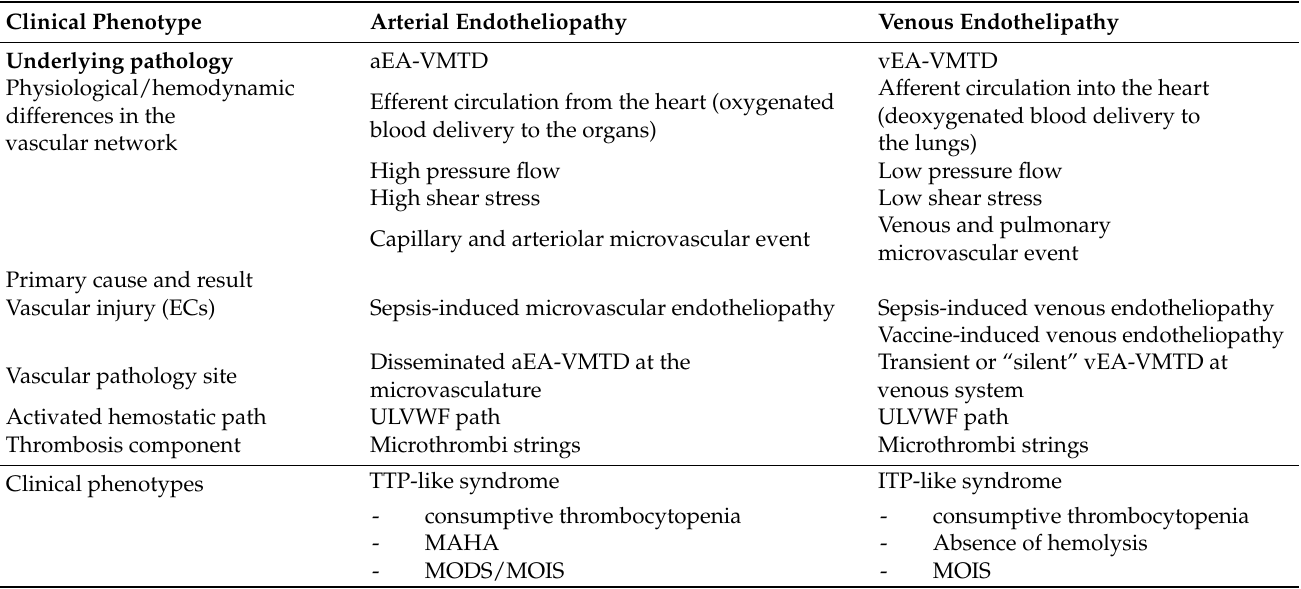
Table 1. Clinical phenotypes and mechanisms of endotheliopathy in arterial and venous systems per “two-activation theory of the